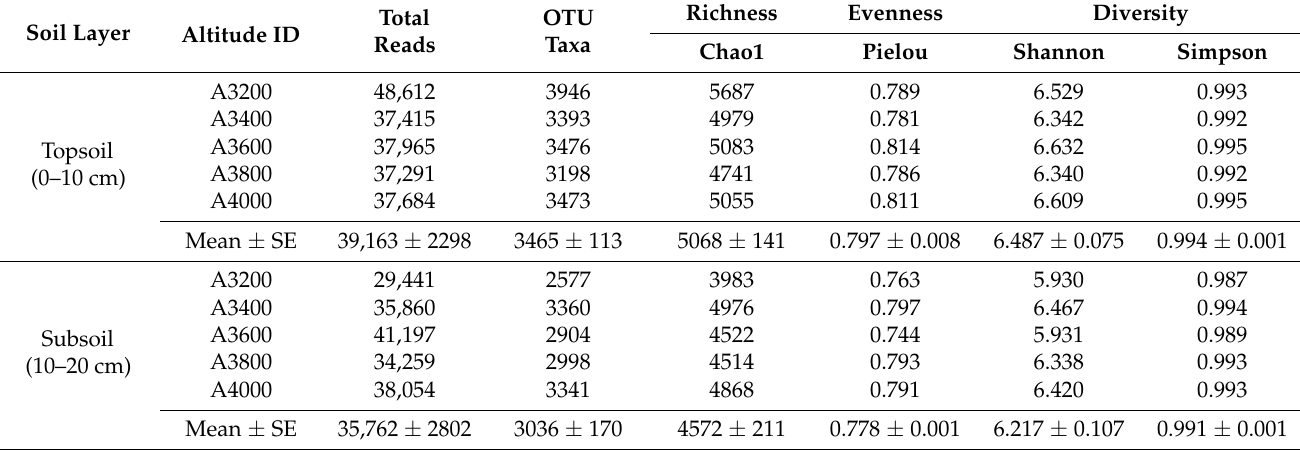
Table 3. Total reads, number of OTU taxa and diversity indices of soil microbial communities. Soil